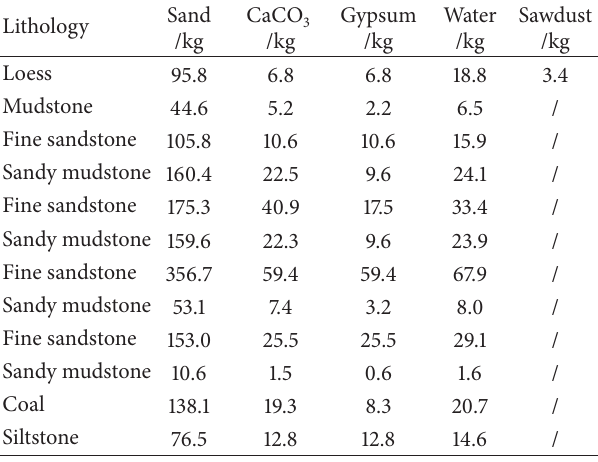
Figure 3: Generalized geological column at studied area. Table 2: The mix proportion of simulated